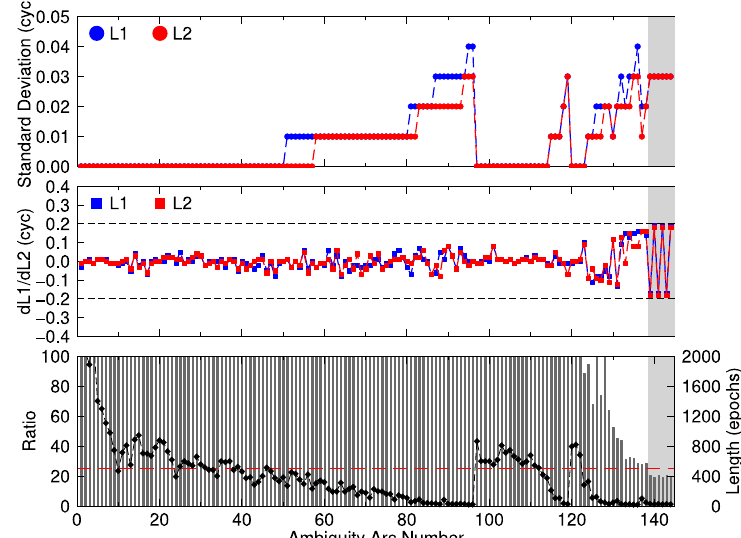
Figure 2. Ambiguity resolution of each arc with L1 + L2 observations. The experimental data is from PERT-CUT0 on DOY 84 2019. The top panel shows the standard deviations of the float ambiguity estimates of L1 and L2. The middle panel indicates the fractional part of the float ambiguity estimates, and the bottom one presents the lower ratio value of L1 and L2 estimates in (24). The red dash line indicates the threshold. The diamond symbol denotes the length of the arc referring to the right vertical axis. The gray background means the unfixed ambiguity arcs.